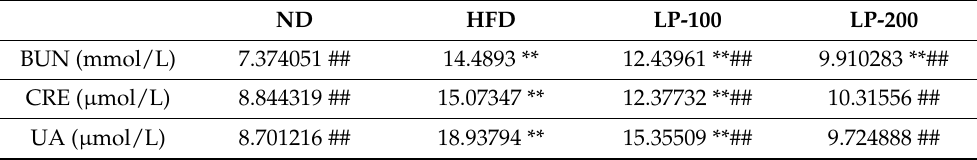
Table 3. UA, CRE, and BUN levels in mice fed HFD.